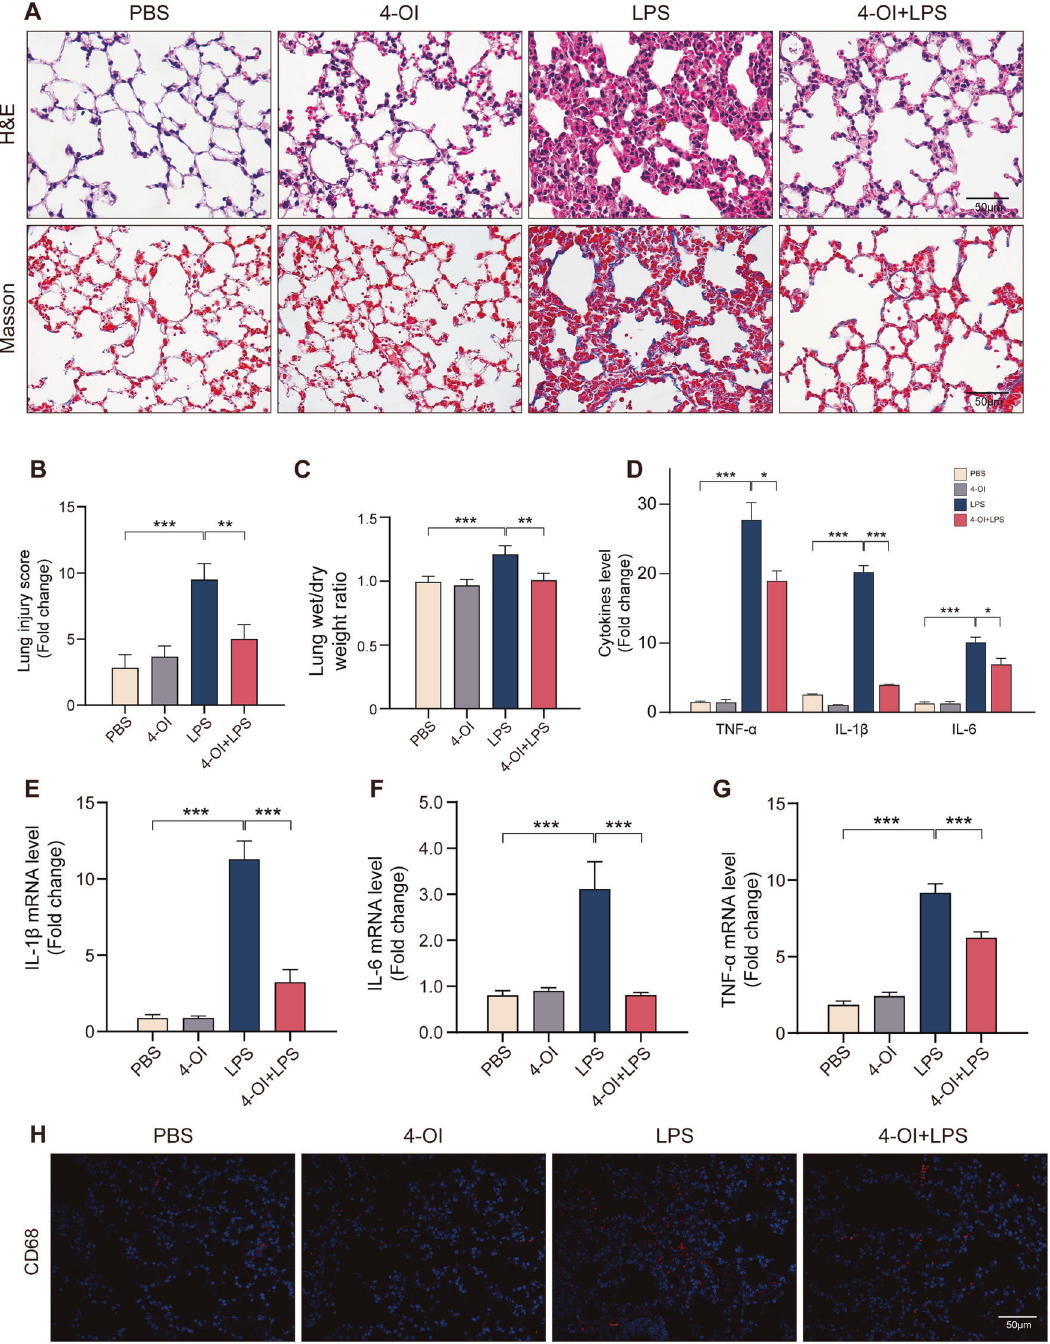
Fig. 1 4-OI signi fi cantly alleviates sepsis-induced ALI in vivo. A Representative images of H&E and Masson staining of lung tissue. Morphology was examined using light microscopy. B Semiquantitative histological scores of lung injury in groups described in panel ( n = 6). C Lung wet-to-dry weight ratio and was determined in all groups ( n = 6). D ELISA for TNF- α , IL-1 β and IL-6 in murine lung tissue ( n = 6). E – G Relative levels of TNF- α , IL-1 β and IL-6 mRNAs in murine lung tissue ( n = 6). H Representative images of immuno fl uorescence staining for CD68 and DAPI in lung tissue. (Data are presented as Mean ± SD. * p < 0.05, ** p < 0.01, *** p <